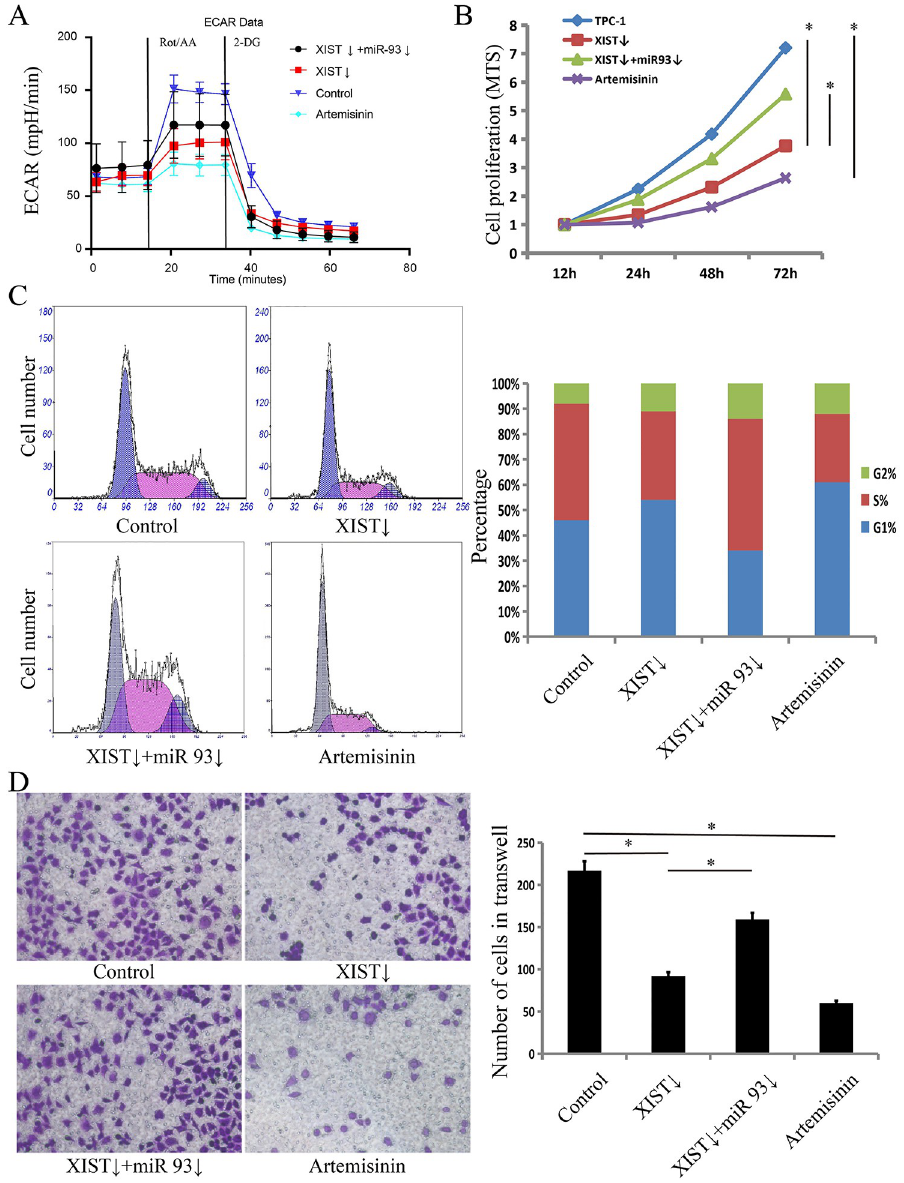
Fig 2. The role of XIST, miR-93 and artemisinin in TC cells. (A) The effect of XIST, miR-93 and artemisinin on the aerobic glycolysis of TC cells by ECAR. (B) The effect of XIST, miR-93 and artemisinin on the viability of TC cells by MTS. (C) The effect of XIST, miR-93 and artemisinin on the cell cycle of TC cells by flow cytometry. (D) The effect of XIST, miR-93 and artemisinin on the metastasis of TC cells by Transwell assays.